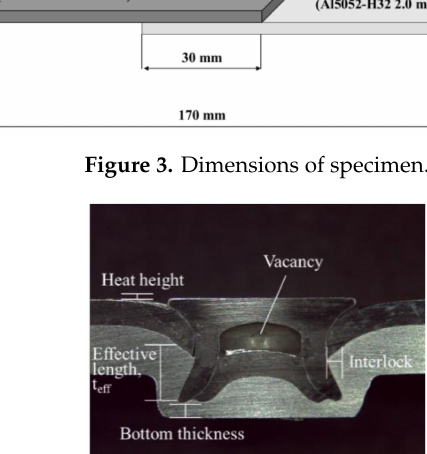
Figure 4. Cross-sectional